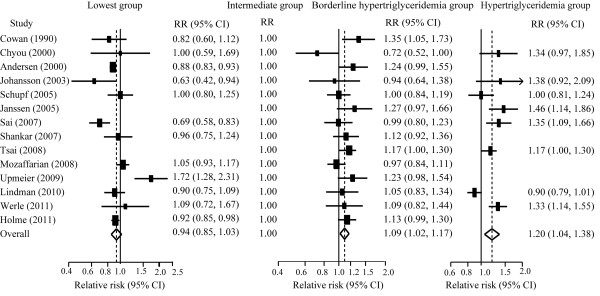
Pooled estimate of RR with 95% CI of all-cause mortality for category analysis. Squares indicate the adjusted relative risk (RR) and horizontal lines indicate the 95% confidence interval (CI). Triglycerides (TG) groups: lowest (<90 mg/dL), intermediate (90–149 mg/dL, the referent), borderline high (150–199 mg/dL), and high (≥ 200 mg/dL).